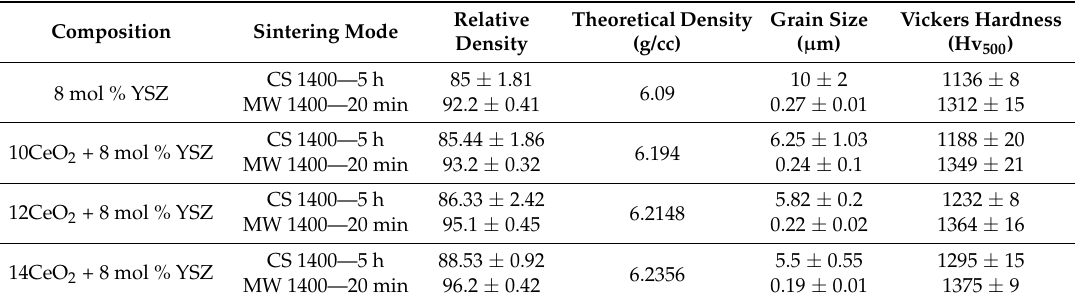
Table 1. Density, grain size and hardness of CeO 2 +YSZ ceramics processed through microwave (MS) and conventional (CS)